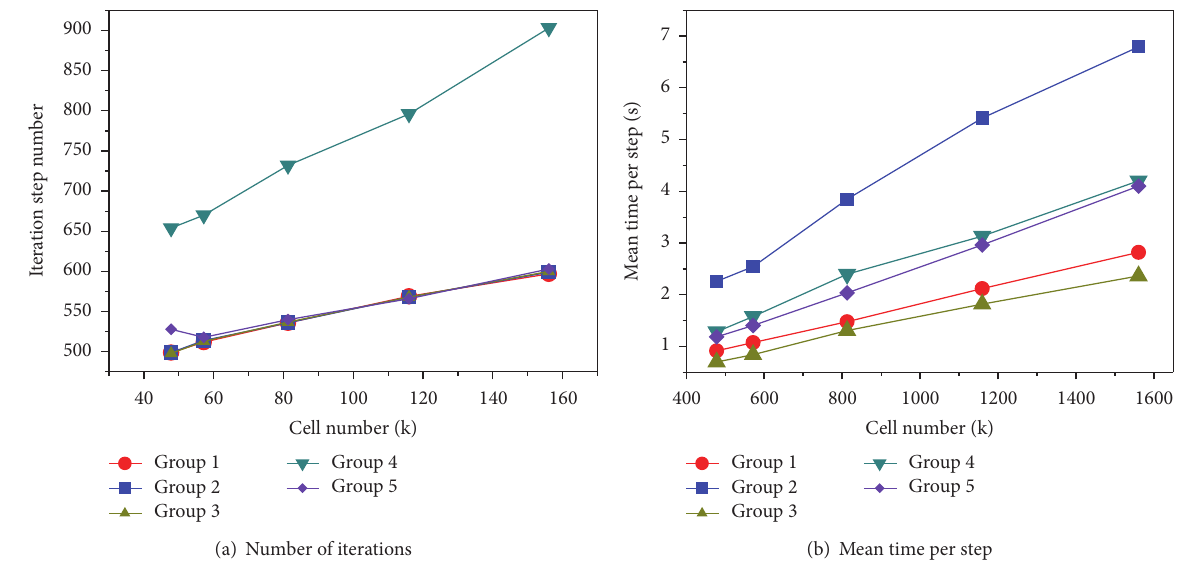
Figure 23: Efficiency analysis for various schemes.